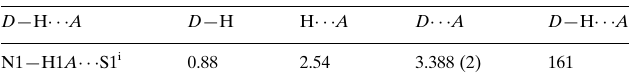
Hydrogen-bond geometry (A˚ , (cid:3)